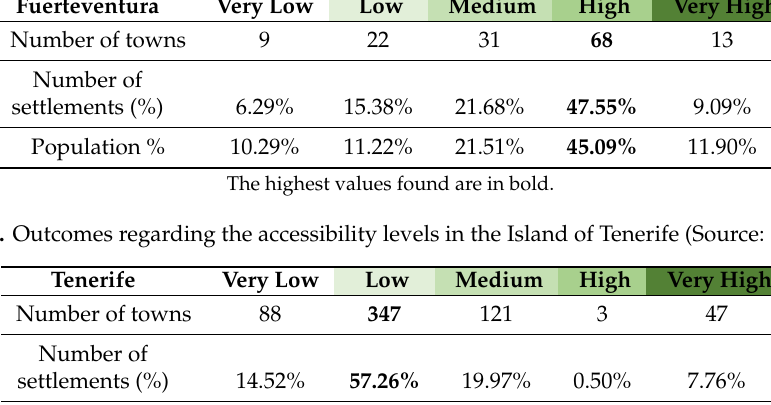
Table 2. Outcomes regarding the demographic dynamics and urban agglomerations classified according to the accessibility levels in the Island of Fuerteventura (Source: authors).